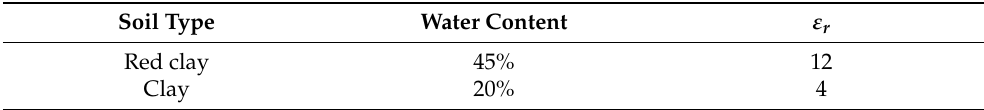
Table 2. Parameters of red clay and